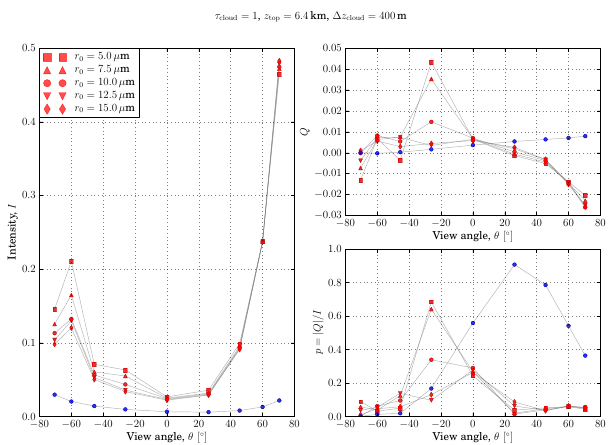
Figure 10. Simulated intensities I (left), Q (upper right) and p (lower right) with respect to θ view for clouds of optical thickness τ cloud = 1 and of varying droplet size r 0 = 5 , 7 . 5 , 10 , 12 . 5 , and 15µm at 750nm ( τ abs , 0 =